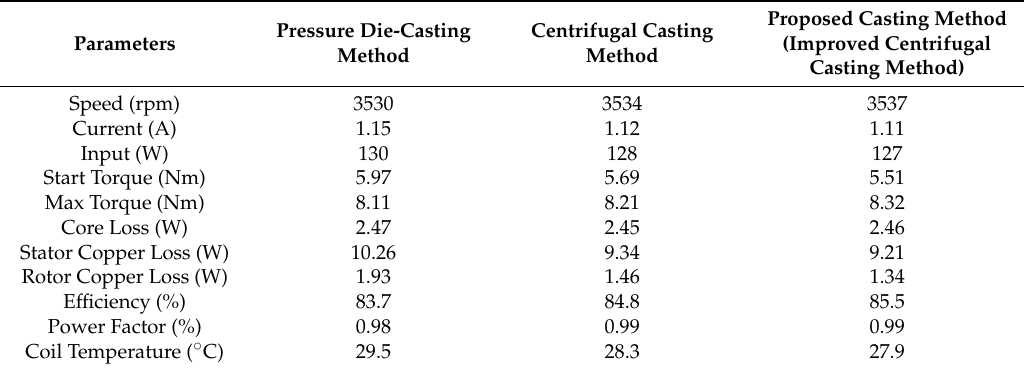
Table 7. The results of applying the stator #2 (115 V/60 Hz).